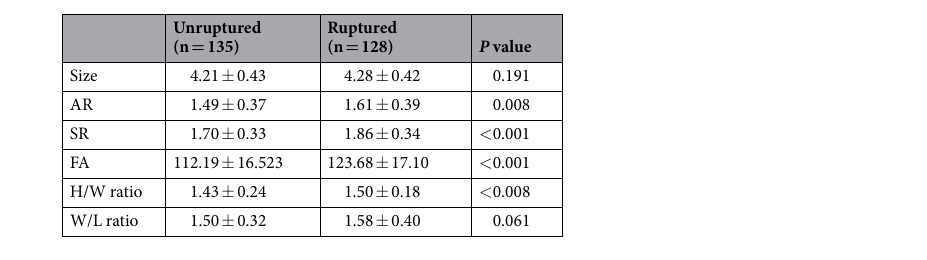
Table 2. Univariate analyses for the morphological parameters measured for ruptured and unruptured small intracranial